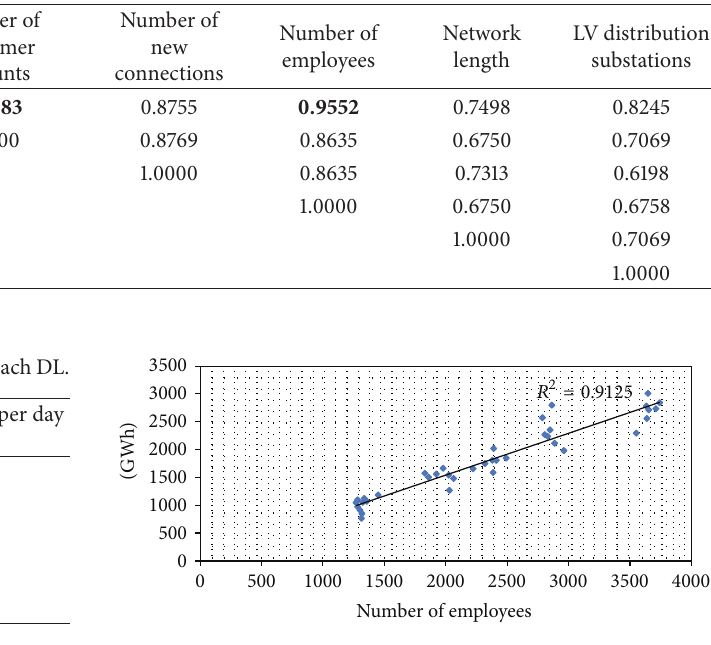
Table 2: Correlation coefficients.